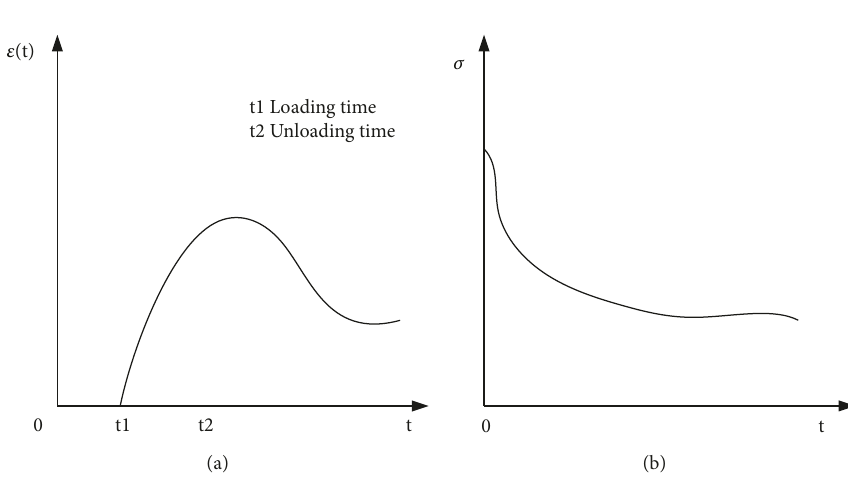
Figure 3: Composites by matrix material.